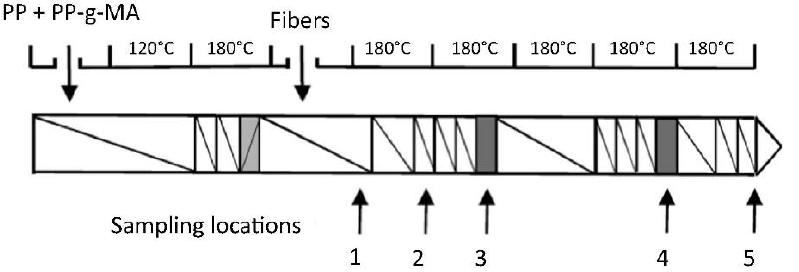
Figure 13. Scheme of the laboratory scale twin-screw extruder (Clextral BC21). Restrictive zones are in grey. Arrows indicate sampling locations [128].